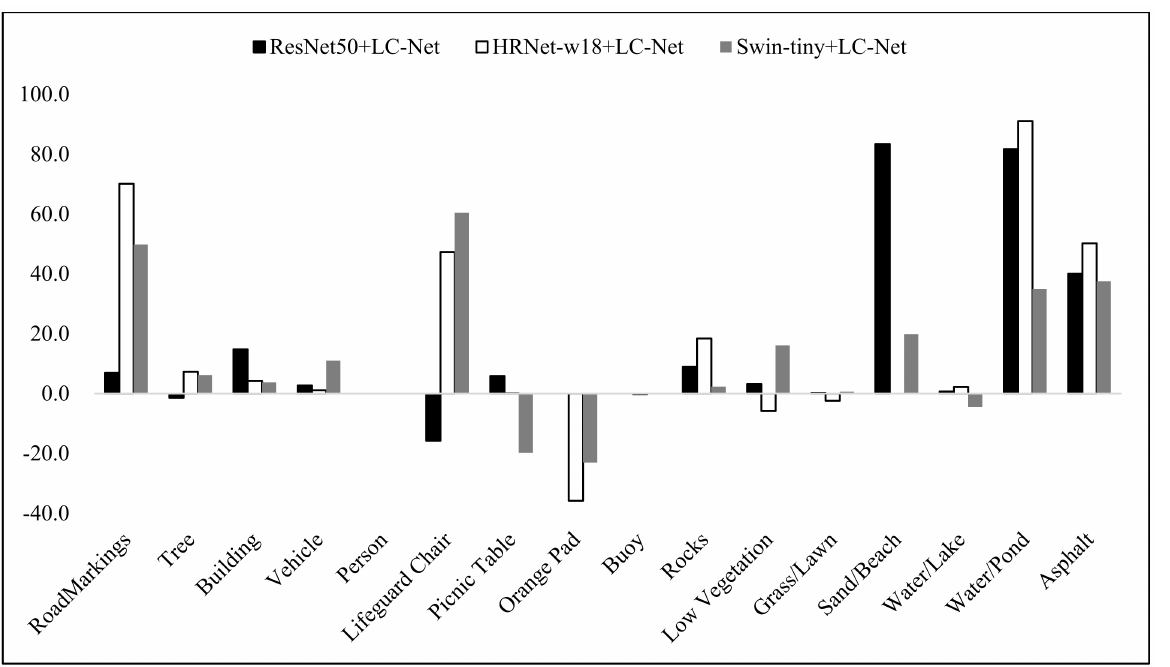
Figure 8. The effect of the addition of LC-Net on the segmentation accuracy of different classes against the DF approach